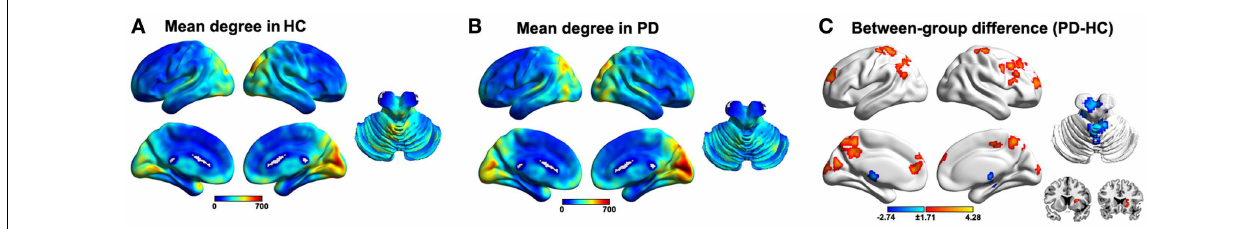
FIGURE 1 | Results of the within/between-group analysis on weighted degree centrality (WDC) . (A) , MeanWDC pattern for the HC group. (B) , Mean WDC pattern for the PD group. (C) , Between-group differences in theWDC.The results were mapped onto the brain surface using the BrainNet viewer